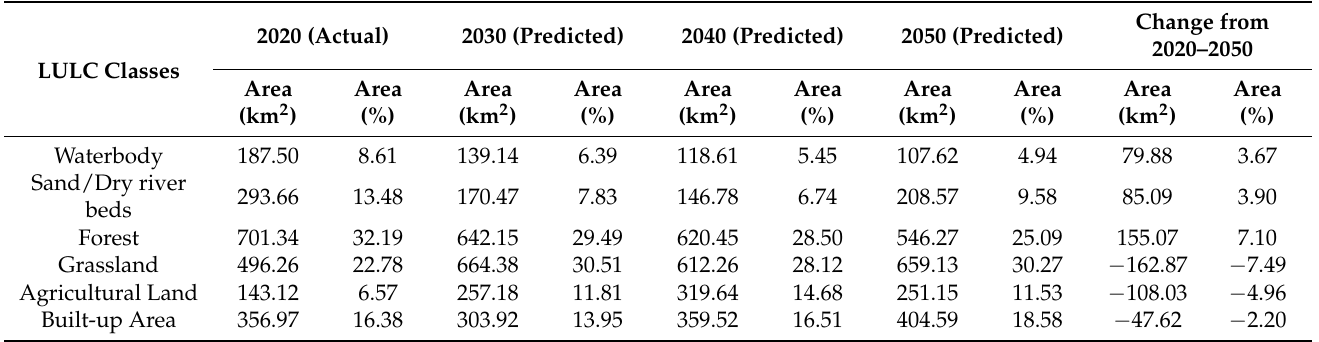
Table 12. Area of the predicted LULC classes of the study